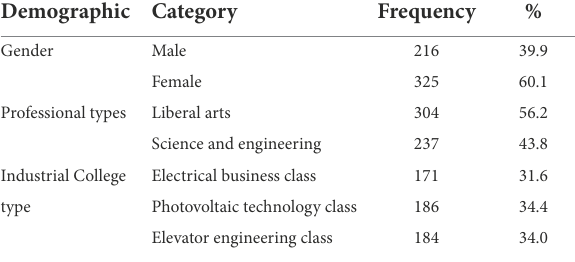
TABLE 1 Demographics of the survey respondents ( N = 541).